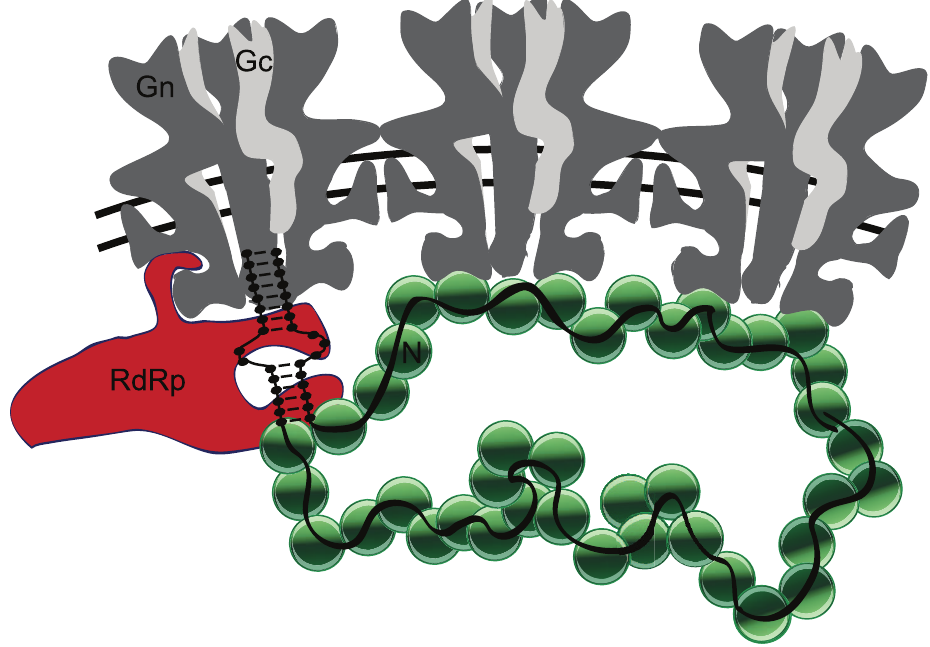
Figure 8. Model for the assembly of RVFV. The diagram represents a slice through the middle of three hexameric capsomers of the virion. Hexameric capsomers contain six copies of heterodimeric Gn (dark gray) and Gc (light gray). Gn is predicted to have two transmembrane domains (TMD). N (green) binds within the first 30 amino acids of cytosolic tail and RdRp (red) binds within the latter 40 amino acids. The genomic segments (black), presumably the terminal regions, bind to the cytosolic tail of Gn. We hypothesize that Gn-N interactions across multiple capsomers induce a membrane curvature that leads to budding of the virion.